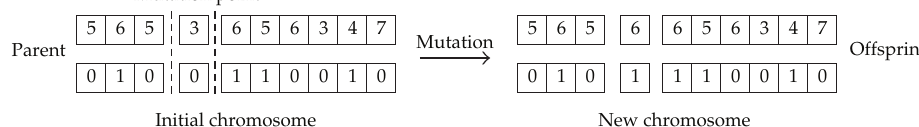
Figure 5: The illustration of the layered mutation operation.